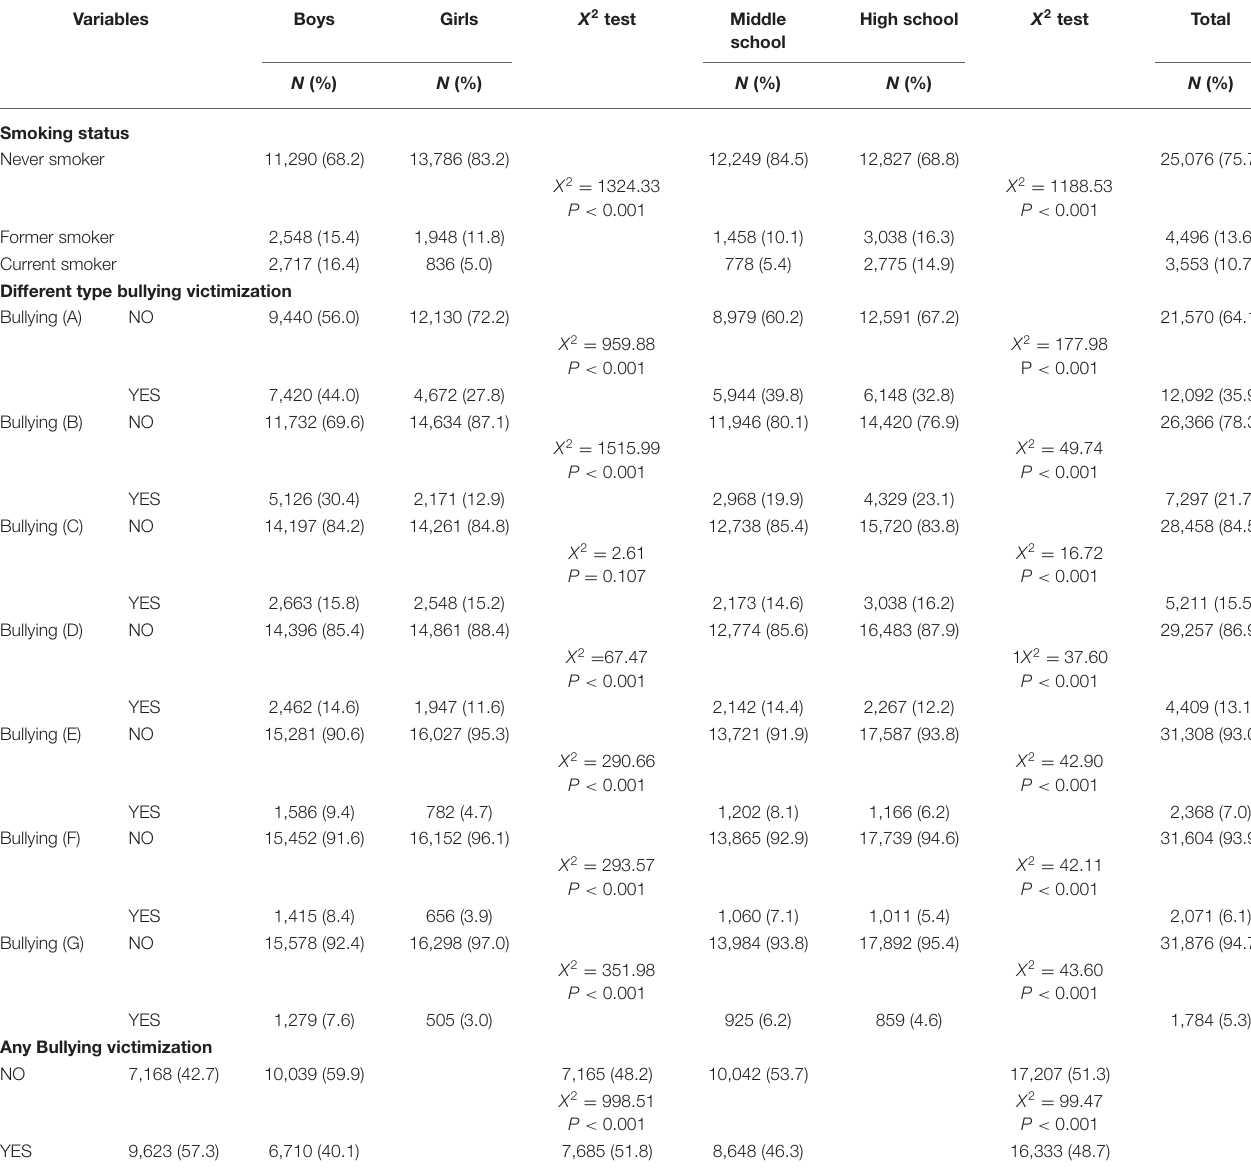
TABLE 3 | Characteristics of smoking and bullying victimization by gender and school